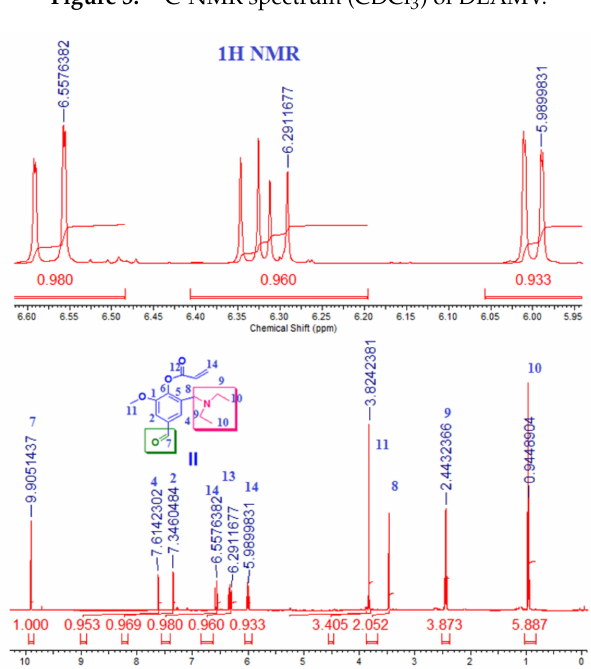
Figure 4. 1 H NMR spectra (CDCl 3 ) of DEAMVA.